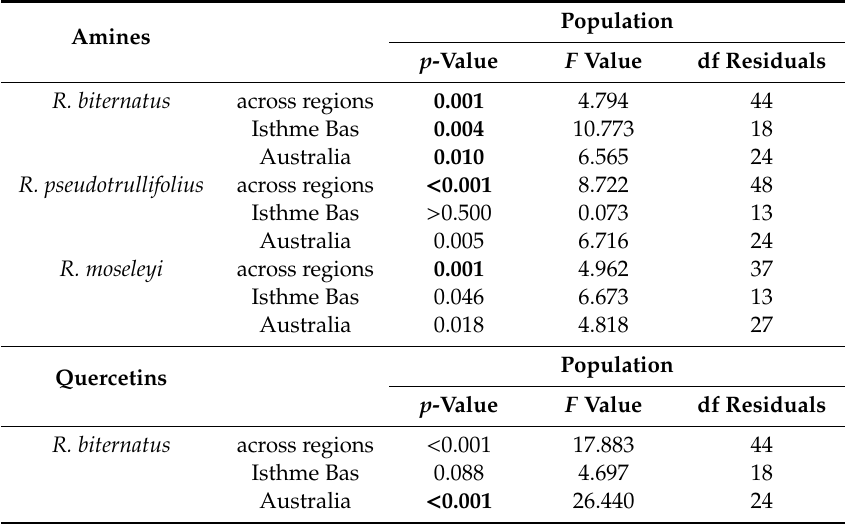
Table 1. Di ff erences in the total contents of amines or quercetins among populations